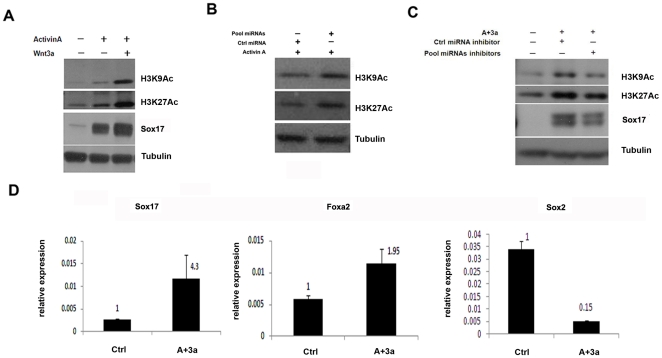
Involvement of histone acetylation in DE differentiation.A. Wnt3a increases H3K9/K27 acetylation level during DE differentiation. Mouse ESCs were treated with Activin A and Wnt3a for 5 days and subjected to western blot analysis on histone H3 acetylation using antibodies against H3K9ac and H3K27ac. Sox17 was examined to confirm DE differentiation. Tubulin was used as the loading control. B. Western blot analysis on histone H3 acetylation using antibodies against H3K9ac and H3K27ac in pooled miRNA over-expressed DE samples. Tubulin was used as the loading control. Please note that over-expression of a subset of miRNAs increases H3K9/K27 acetylation level. C. Western blot analysis on Sox 17 and histone H3 acetylation using antibodies against H3K9ac and H3K27ac in pooled miRNA inhibitors over-expressed DE samples. Tubulin was used as the loading control. D. the H3K9 acetylation level of Sox17, Foxa2, and Sox2 promoter regions was quantified by ChIP-qPCR. The data was normalized to input; fold change values were labeled as indicated. Data are expressed as mean percentage ± SD. A: Activin A; 3a:Wnt3a.